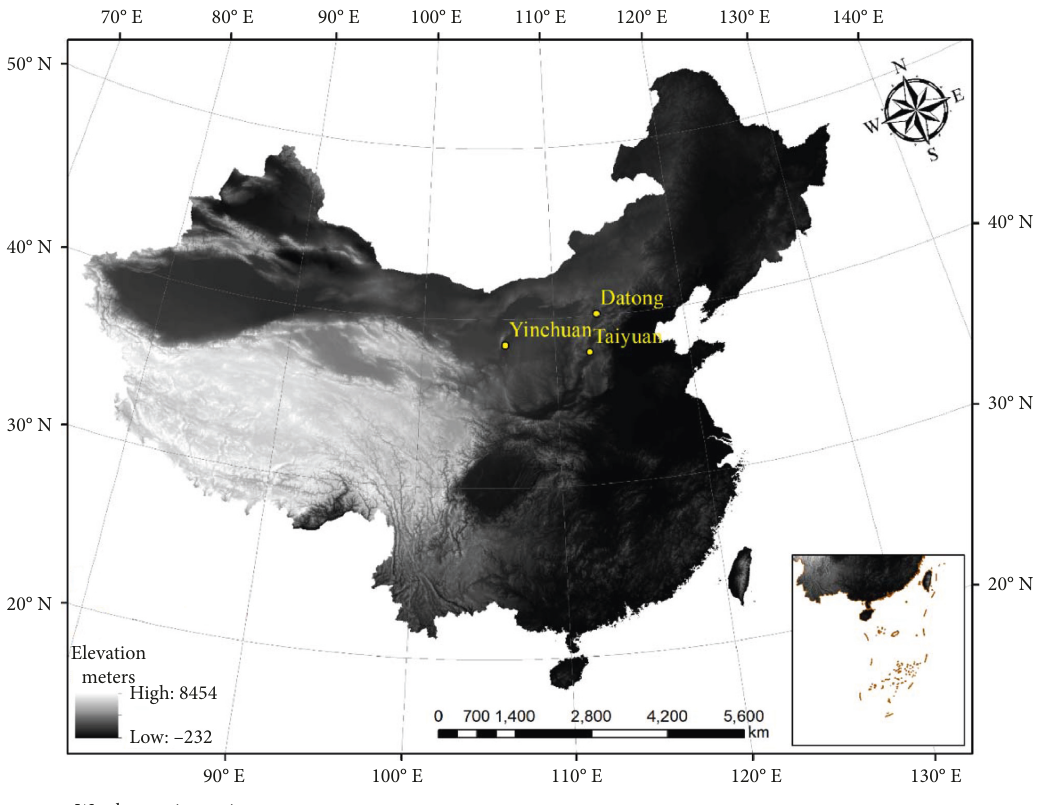
Figure 1: The geographic information of the three weather stations in this Table 1: Statistics of the meteorological data of the three stations during the training and testing stages in the study. Station/ Meteorological data